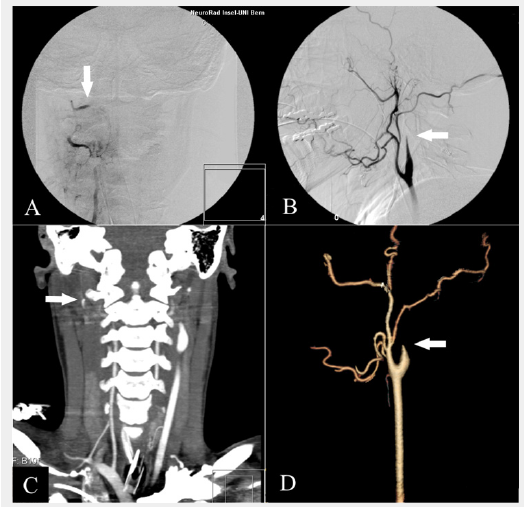
“Gold Standard” DSA: AP view of the right vertebral artery (A) and lateral view of the right carotid artery (B). The stop of contrast in the intersection between extra- and intradural segment of the vertebral artery and the cervical segment of the internal carotid artery are typical angiographic findings (white arrows); in DSA, they are rated as proof of cerebral circulatory arrest. From the axial CT-Dataset similar views as DSA can be obtained in 2D- (C; vertebral artery) or 3D-reformations (D; carotid artery). For the evaluation of brain death we only use the axial source images. Doing reformations is time consuming, operator dependent and not established in the literature for the determination of brain death. They are shown here only for exemplary purposes and nicely illustrate the lack of intracranial blood